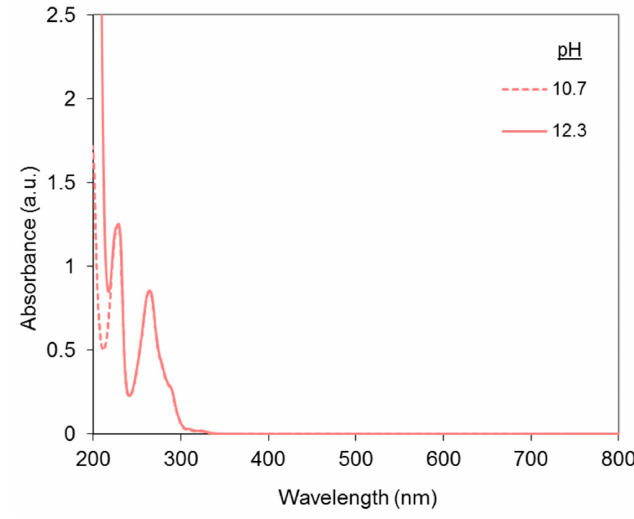
Figure 6. Absorbance spectra of 1,10-phenanthroline at pH 10.7 and 12.3, with [Phen] = 30 µ M (equivalent to the amount of phenanthroline with the following molar ratio: DR81:Cu = 1:1.5, Cu:Phen = 1:2, and [Cu] = 15 µ